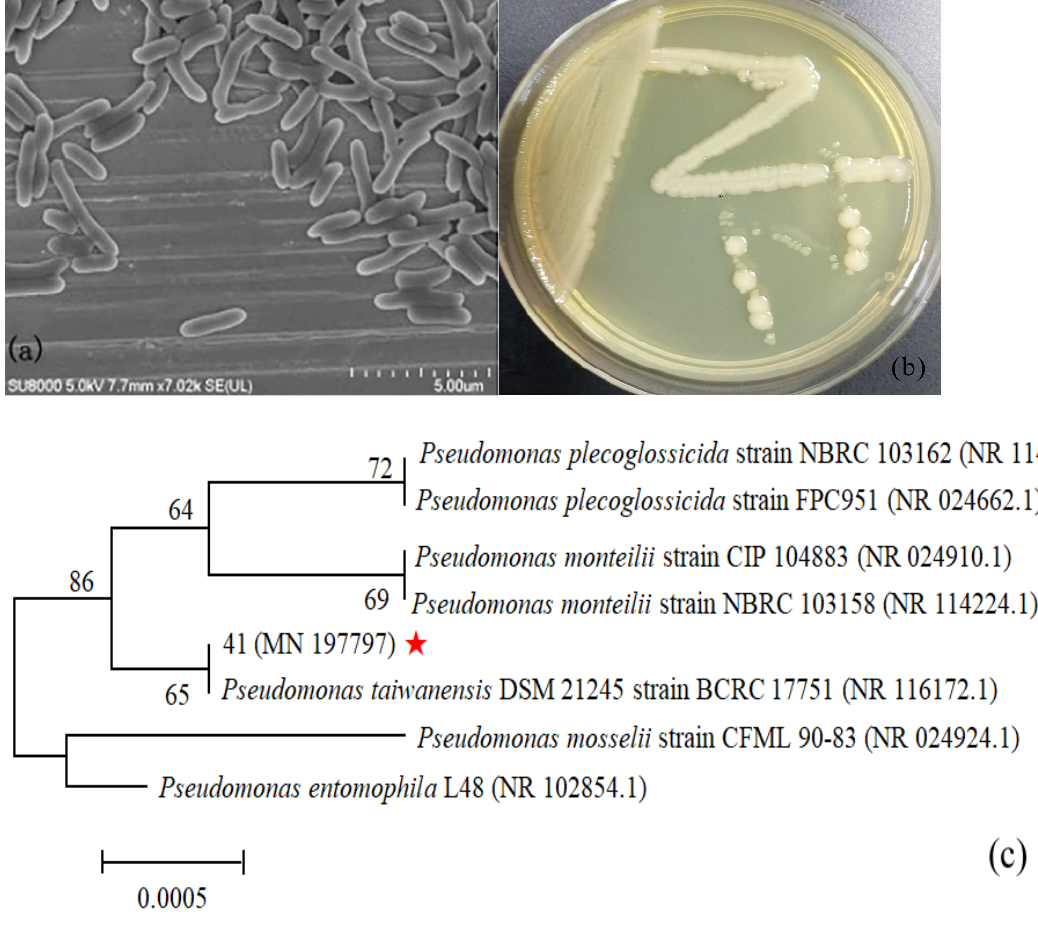
Figure 1. Identification of strain 41: ( a ) SEM image; ( b ) colony characteristics; ( c ) phylogenetic tree of strain 41 based on 16S rRNA gene sequence, ★ represented strain 41.